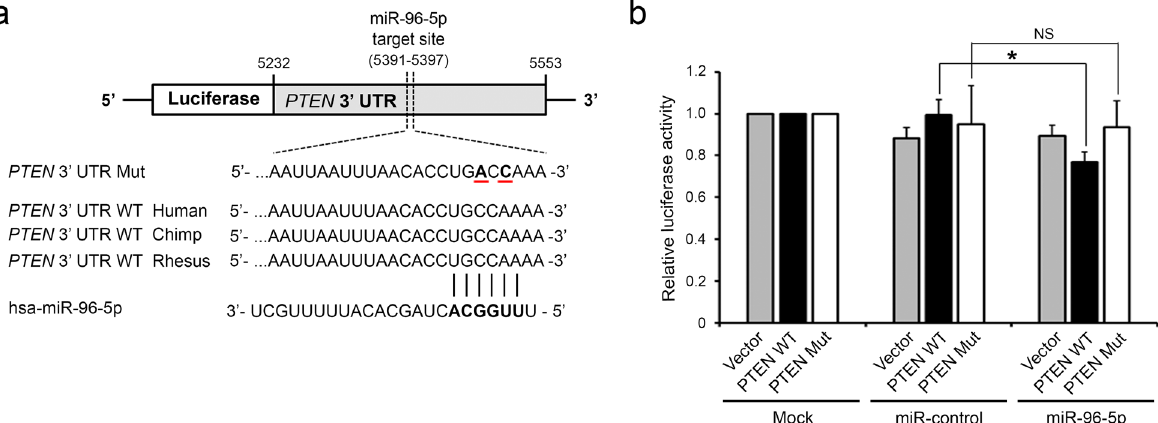
Figure 5. miR-96-5p directly represses PTEN expression. ( a ) Schematic representation of the predicted miR- 96-5p target site sequence within the 3 ′ UTR of PTEN . Six nucleotides within the target site are complementary to the seed sequence of miR-96-5p. ( b ) Luciferase reporter assay. 293 T cells were co-transfected with luciferase reporters carrying either the wild-type PTEN 3 ′ UTR (PTEN WT) or the mutagenized PTEN 3 ′ UTR (PTEN Mut), as well as 50 nM negative control mimic (miR-Control) or miR-96-5p mimic. Data are presented as mean ± s.e.m. (n = 3). Significant results are presented as * P <